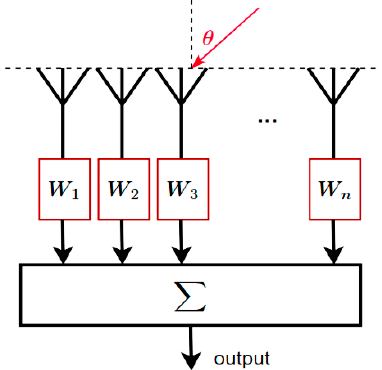
Figure 10. Block diagram of Rx antenna array.